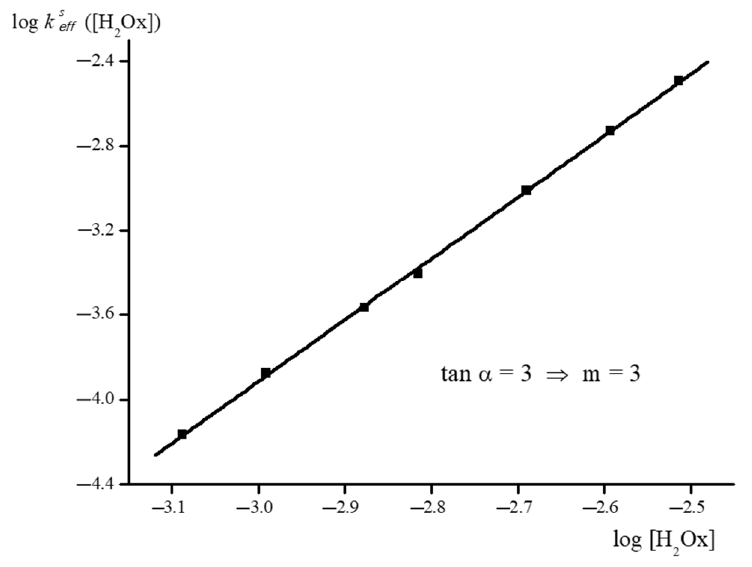
for the complex FeOx 3 (BCH 3 ) 2 ( 5 ) at [Fe 2+ ] = 2 × 10 − 5 mol L − 1 , [H 2 Ox] = 1.5 × 10 − 3 mol L − 1 , [CH 3 B(OH) 2 ] = 5 × 10 − 3 mol L − 1 and pH = 3.75.